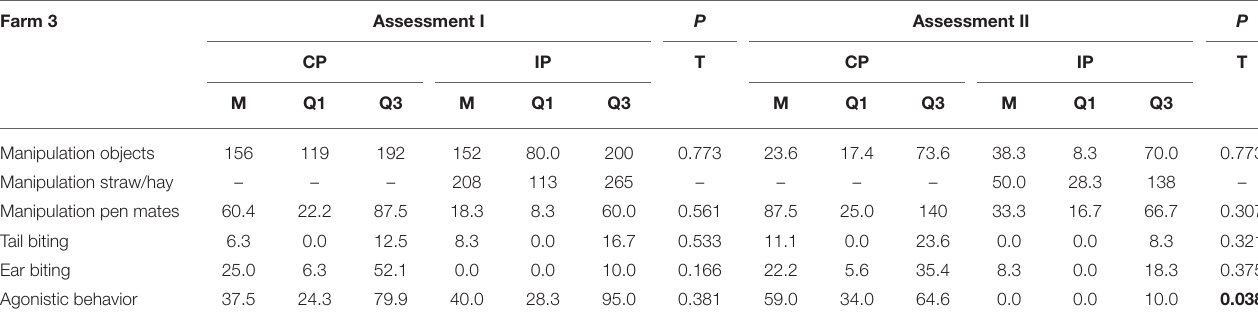
TABLE 6 | Incidence of behaviors (number of events/100 animals * 10min; median M, lower quartile Q1 and upper quartile Q3) for pigs in IP (improved pens) and CP (control pens) during assessments I (baseline) and II (middle of the fattening period) on Farm 3. Farm